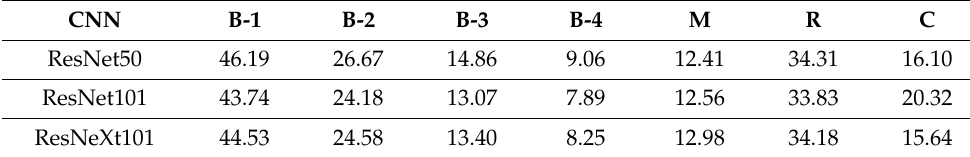
Table 4. Performance on test splits for attention model.